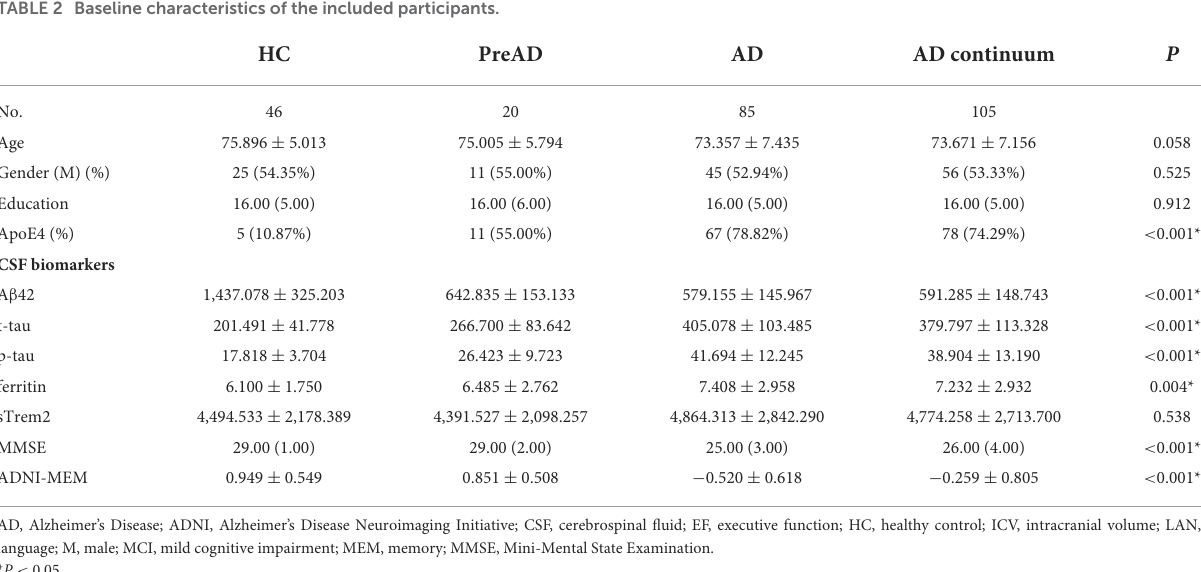
FDR = 0.138) and p-tau ( β = 0.167, SE = 0.102, P = 0.104, FDR = 0.260) in any participants (Supplementary Table